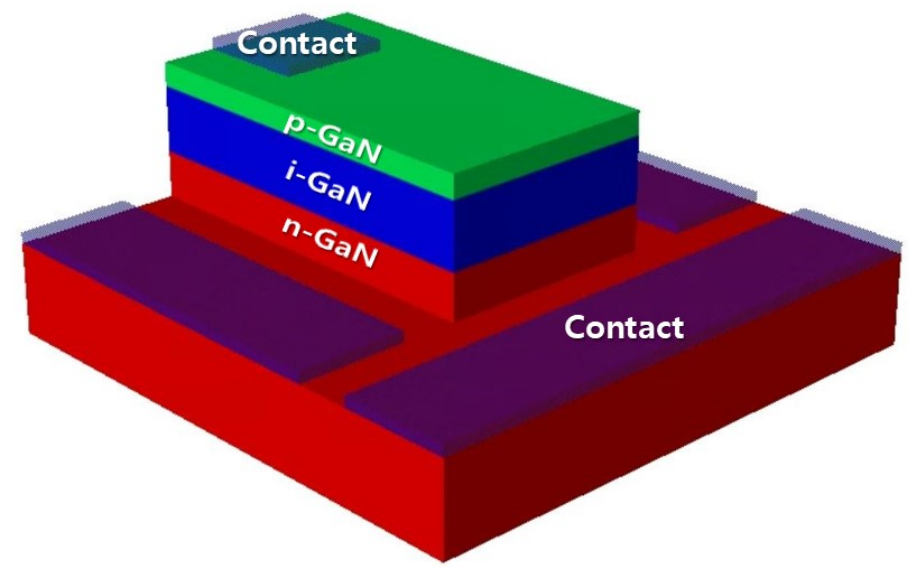
Figure 1. 3-D schematic of the p-i-n diode structure for betavoltaic (BV) cell.